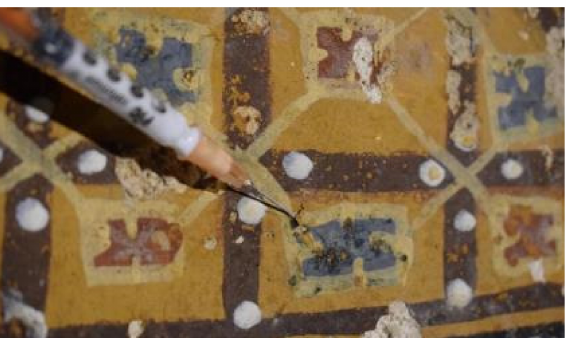
Figure 8. Treatment of defects of adhesion of the paint layer with N ANO LAQ300 by means of a